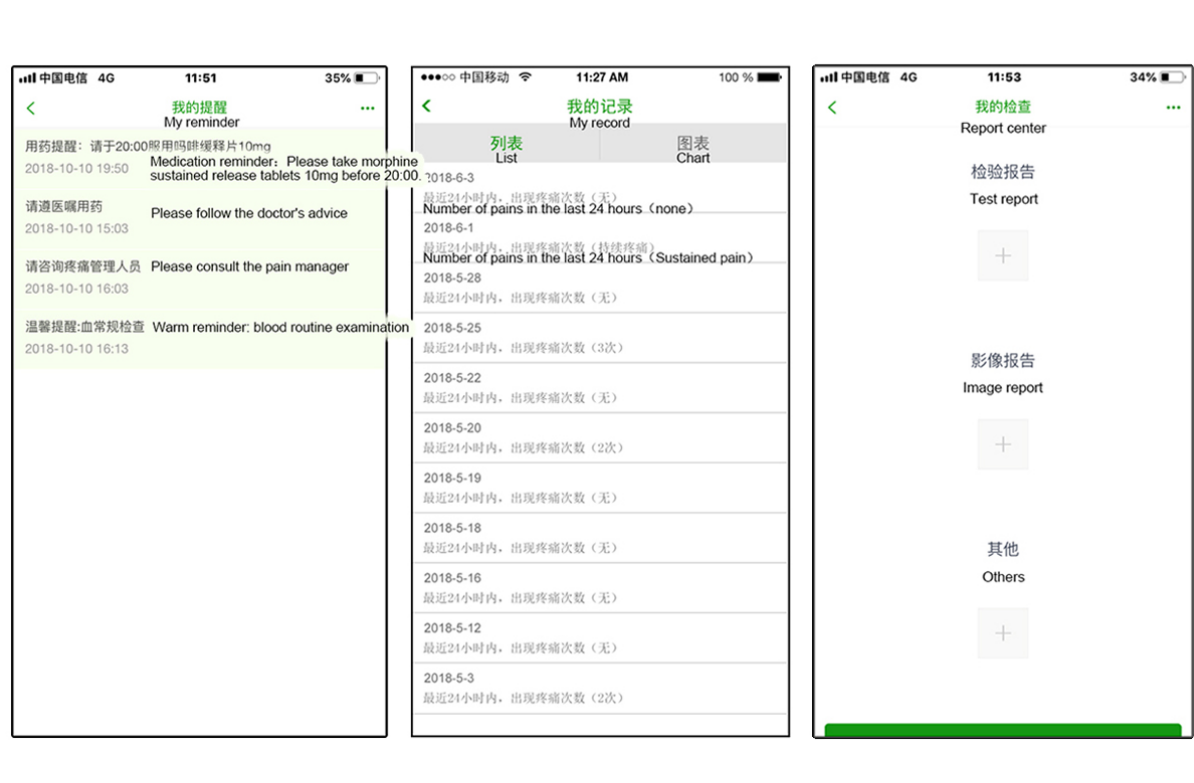
Figure 4. Screenshots of the reminds, records, and report center modules.